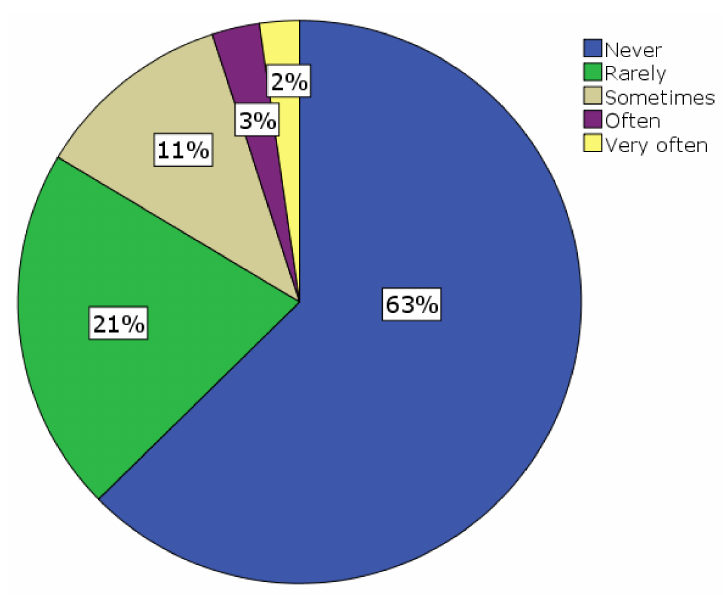
Figure 6. How often does being self-conscious prevent you from walking in Galway?